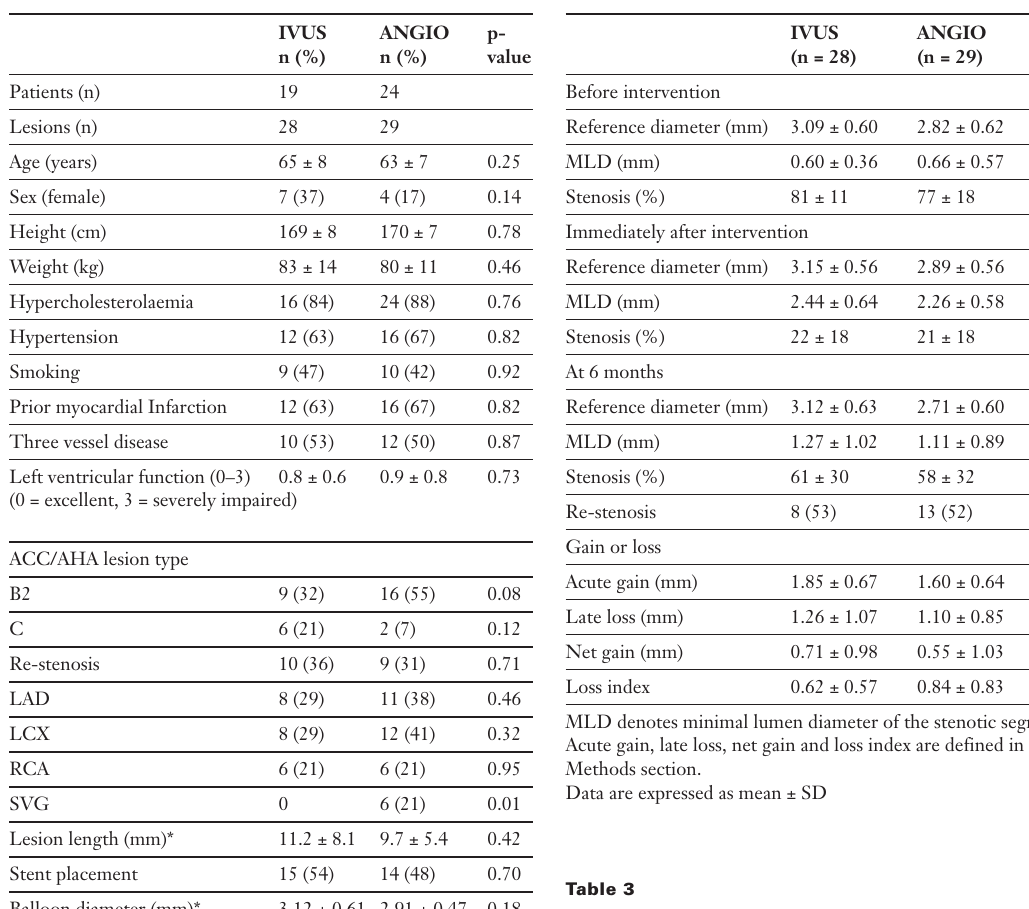
Baseline patient, lesion and procedural characteristics.